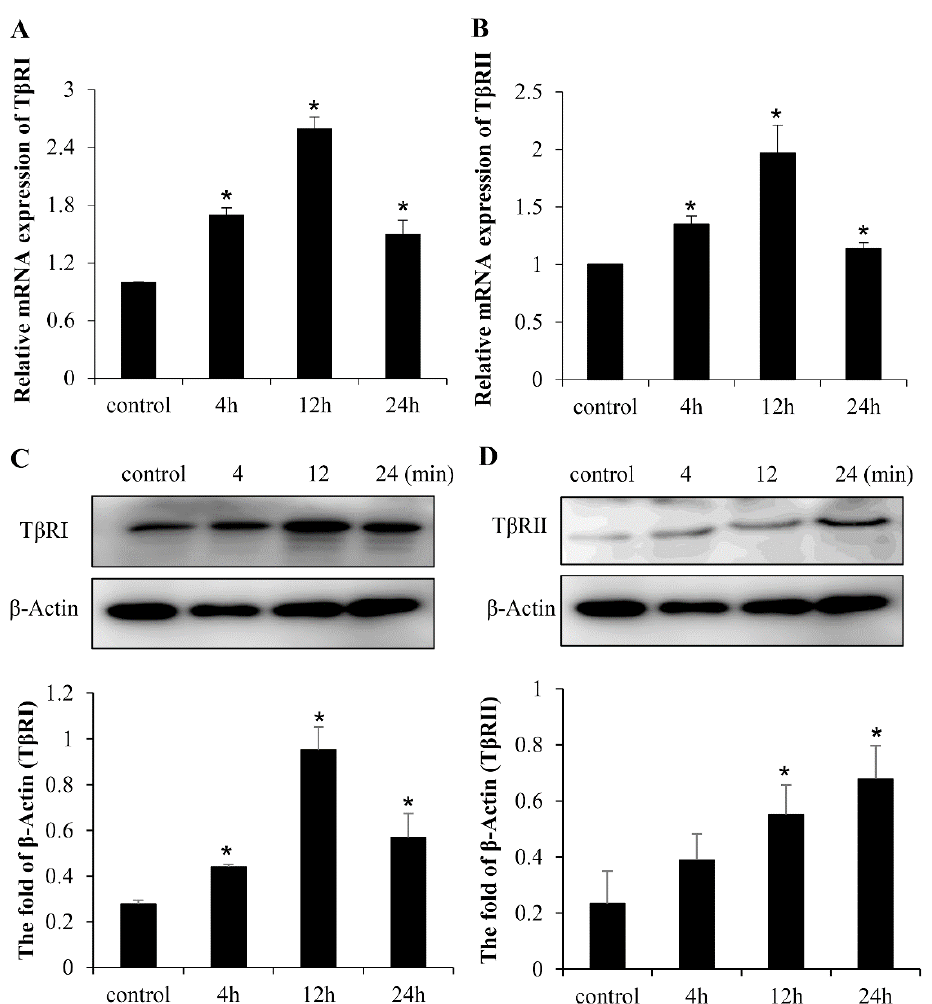
Figure 3. E ff ects of LF on the expression of TGF- β receptors in C3H10T1 / 2 cells. Time-course analysis Figure 3. Effects of LF on the expression of TGF-β receptors in C3H10T1/2 cells. Time-course analysis of mRNA expression of TGF- β receptor I ( A ) and receptor II ( B ) after treatment with 100 µ g / mL LF of mRNA expression of TGF-β receptor I ( A ) and receptor II ( B ) after treatment with 100 μg /mL LF in MSCs. Time-course analysis of the expression of TGF- β receptor I ( C ) and receptor II ( D ) after in MSCs. Time-course analysis of the expression of TGF-β receptor I ( C ) and receptor II ( D ) after treatment with 100 µ g / mL LF on the protein level in MSCs. Values are mean ± SDs, n = 3 (means of treatment with 100 μg /mL LF on the protein level in MSCs. Values are mean ± SDs, n = 3 (means of five replicates). (* p < 0.05 versus control five replicates). (* p < 0.05 versus control group).